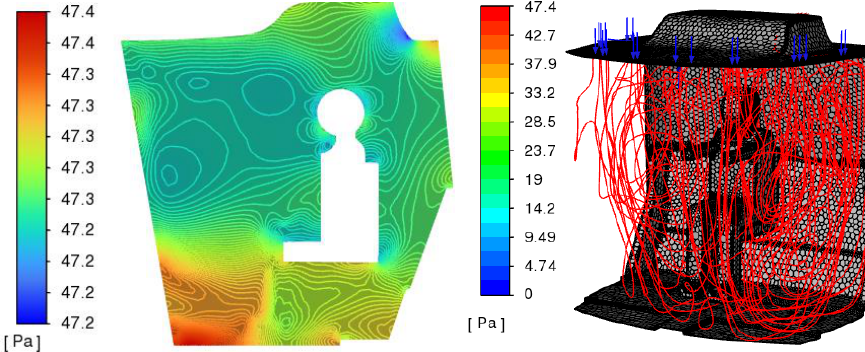
Figure 8. Relative pressure, Pa.